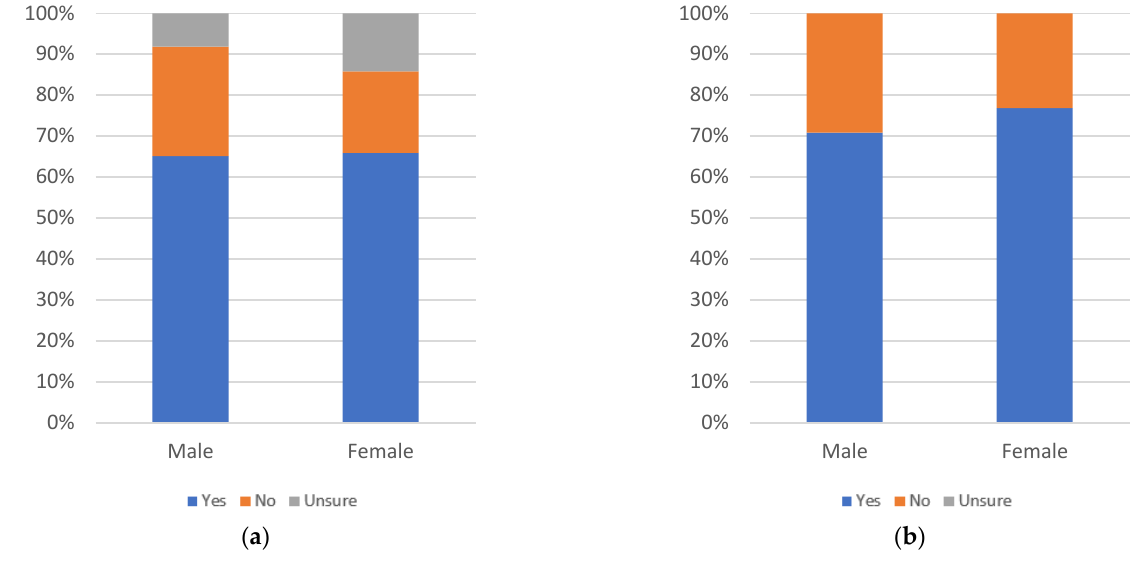
Figure 61. Label use, by gender: ( a ) with uncertain respondents (left) and ( b ) without uncertain respondents (right).